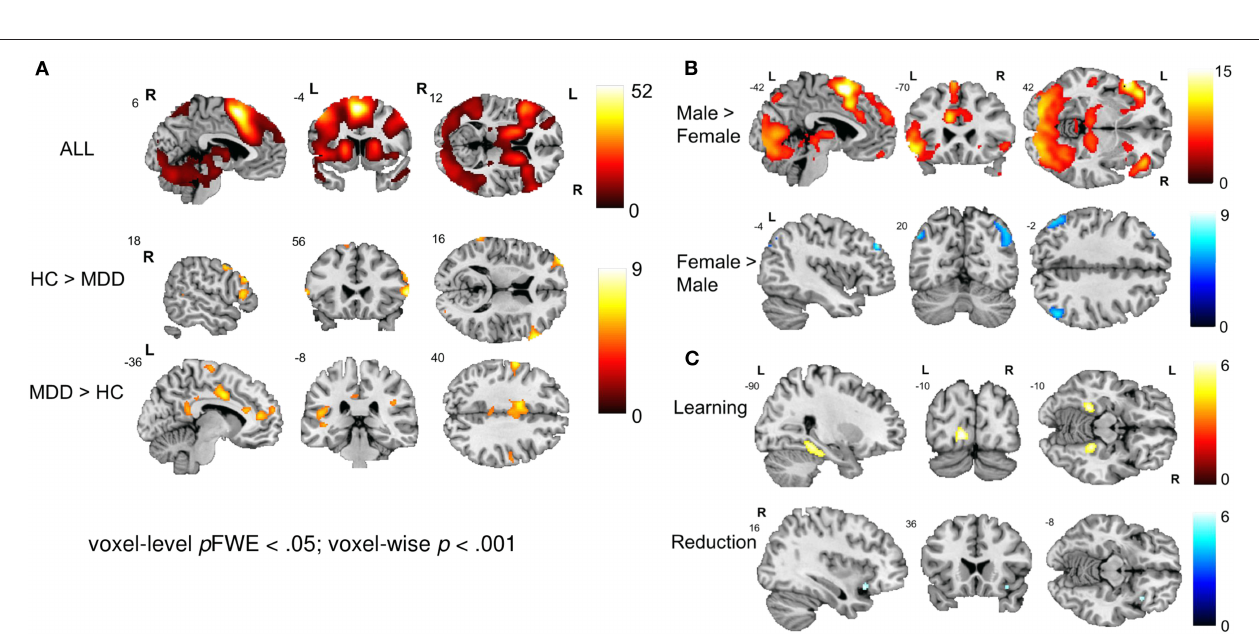
FIGURE 3 | Neural correlates of emotion regulation. (A) The main effect of group revealed a widespread network active during NF including the bilateral prefrontal cortex, precentral gyrus, SMA, MCC, bilateral occipital and superior parietal areas, thalamus, and cerebellum. Healthy individuals showed a stronger engagement of prefrontal areas while patients showed more activation in cingulate areas. (B) The main effect of gender revealed engagement of an extensive network during emotion regulation in males including the bilateral prefrontal cortex, SMA, dmPFC, bilateral precentral and occipital gyrus and bilateral thalamus. Female participants showed stronger activation in the bilateral angular gyrus. (C) Learning and reduction across NF runs 1 to 4. Overall, participants showed an increase in the bilateral fusiform gyrus and occipital lobe as well as a decrease of activation in the right insula and the MCC.